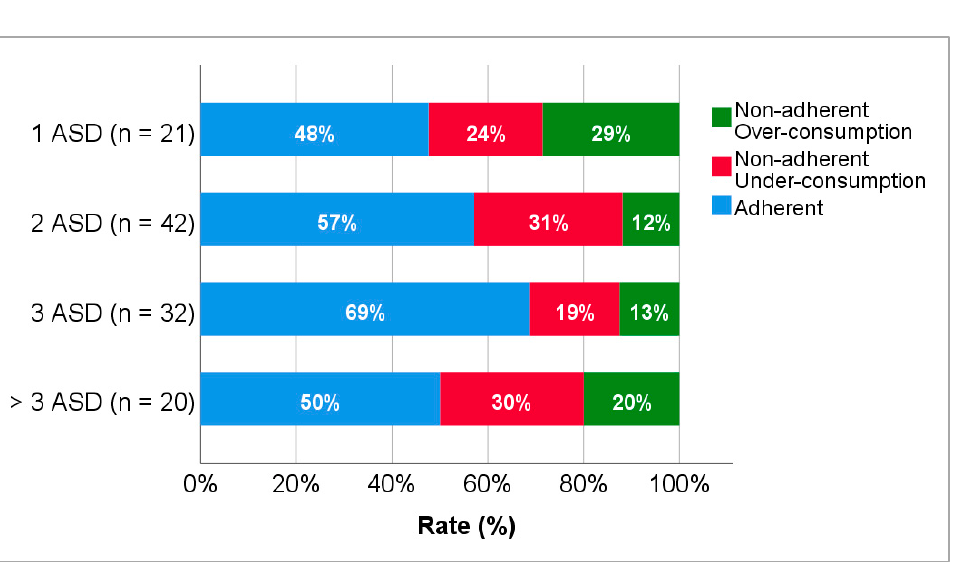
Figure 5. Adherence to levetiracetam treatment according to the number of antiseizure drugs. ASD, antiseizure drug.